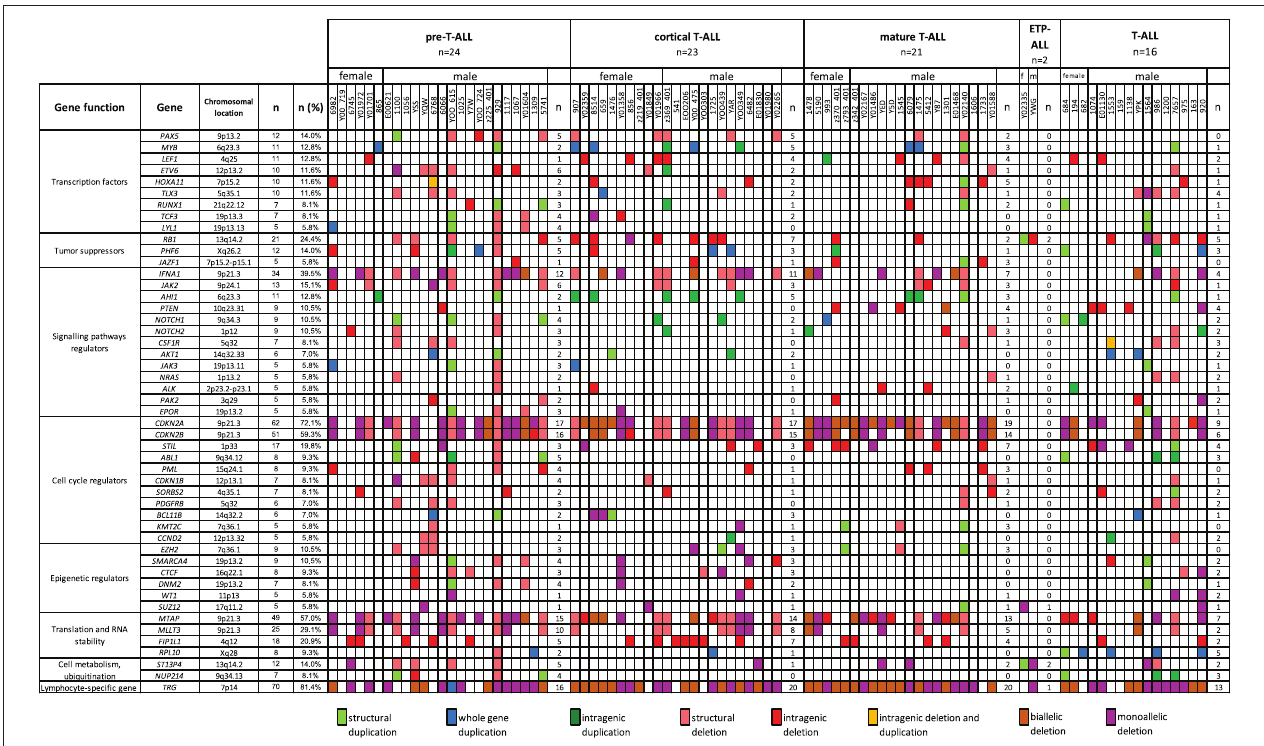
FIGURE 7 | Overview of molecular alterations identified in 86 samples according to particular subtypes of T-ALL. Heat map represents genes in which CNAs have been identified in at least 5% of patients.